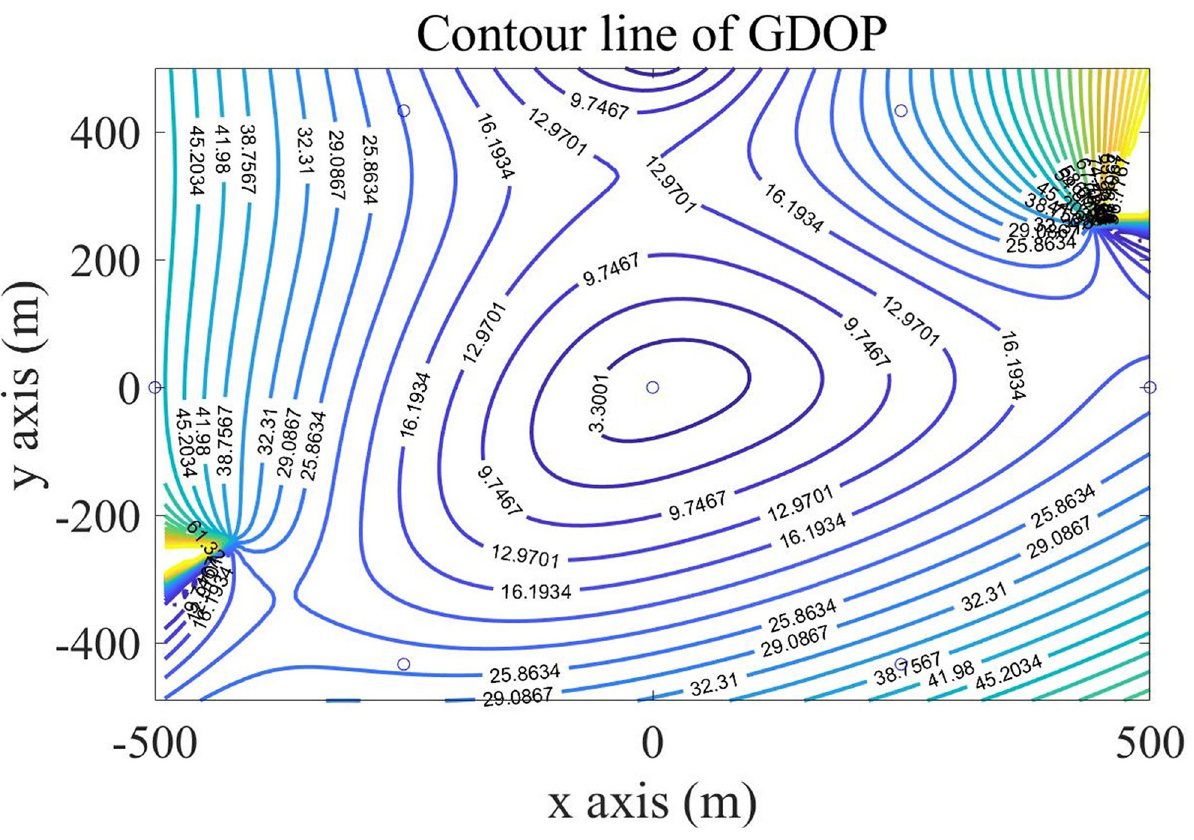
Fig 10. Contour lines of GDOP in parallelogram